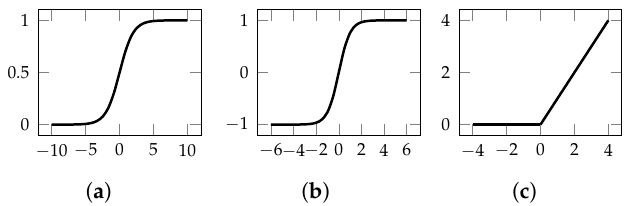
Figure A3. Most commonly used activation functions: ( a ) sigmoid, ( b ) hyperbolic tangent and ( c ) rectified linear unit